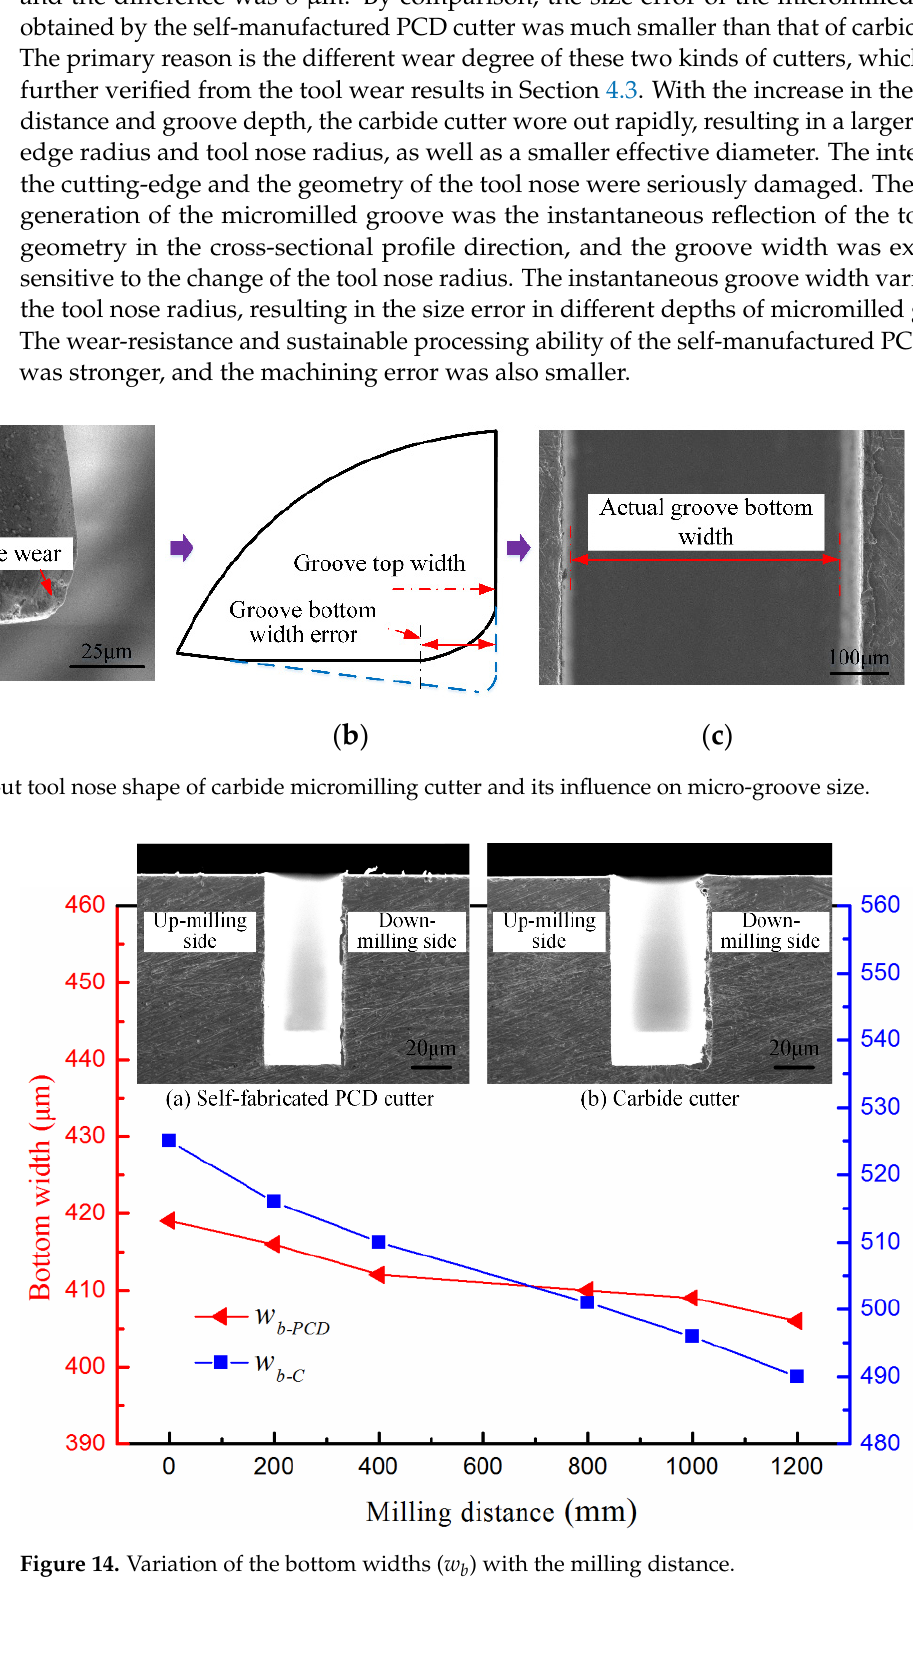
Figure 12. Surface morphology of the bottom boundary of side-walls by the self-fabricated PCD cutter. ( a ) 2D morphology; ( b ) 3D morphology.